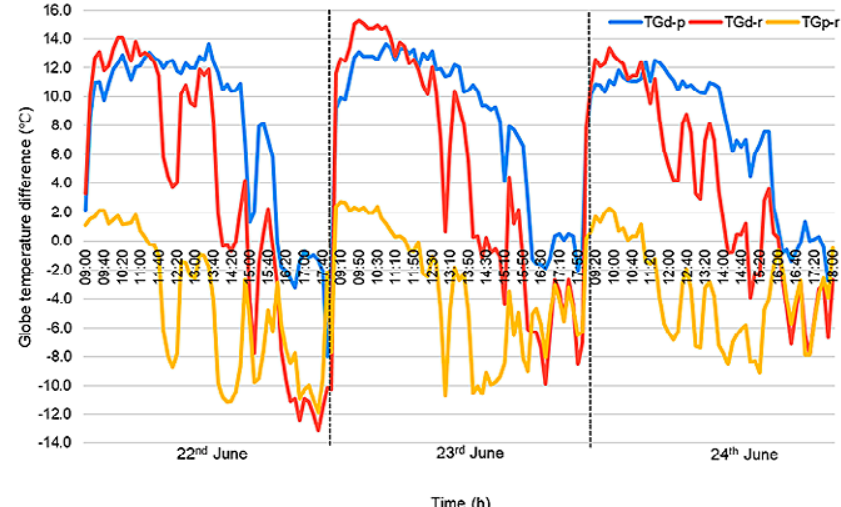
Figure 6. Temporal variation of T in Banja Luka (Bosnia and Herzegovina) in the period 22-24 June 2021 g (measurement period 9-18 h CEST). NOTE: TG represents globe temperature difference between downtown d-p and urban park; TG represents globe temperature difference between downtown and riverside; d-r and TG represents globe temperature difference between urban park and p-r